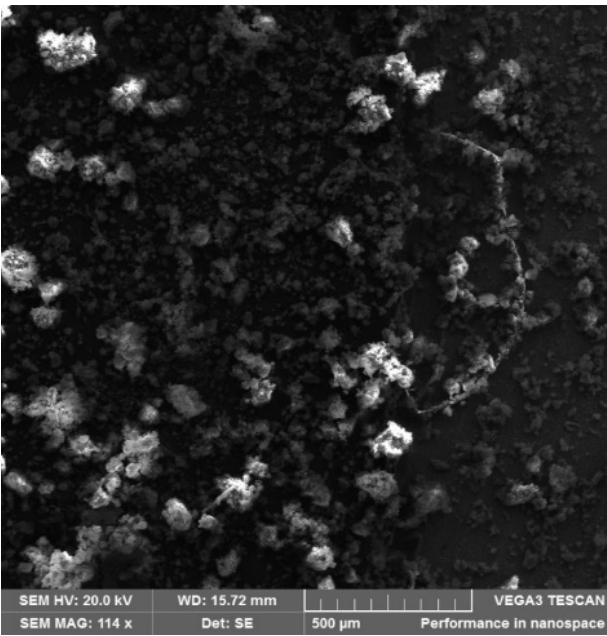
Figure 1. SEM image of crushed raw PAN.